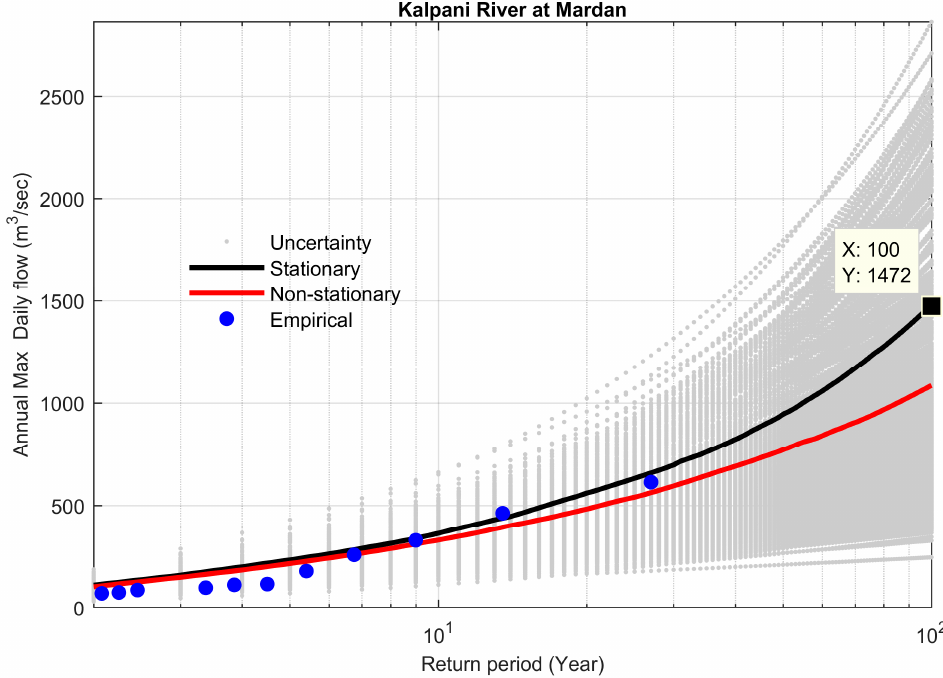
Figure 18. Comparison between non-stationary and stationary FFCs at site 18, along with non-stationary uncertainty bounds for the year 2009.